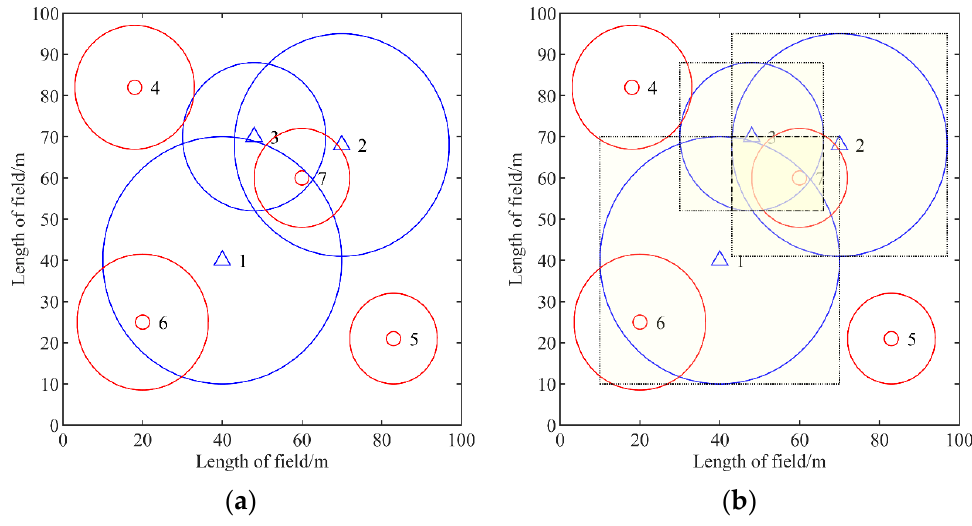
Figure 5. Impact of heterogeneity of communication radius on network communication: ( a ) original communication radius; ( b ) square communication radius.